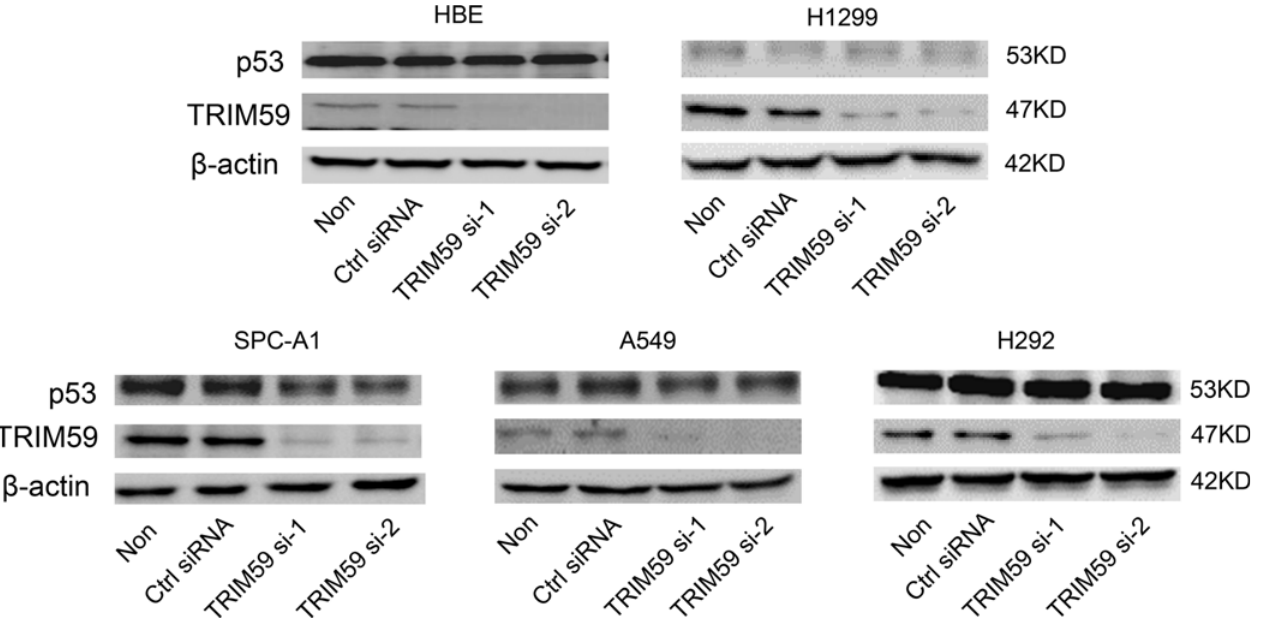
Fig 6. TRIM59 promotes NSCLC cell growth not through p53 signaling pathway. Four types of indicated NSCLC cells and HBE cells transiently transfected with TRIM59 siRNA-1, TRIM59 siRNA-2, control siRNA or untransfected were cultured in RPMI 1640 with 10% FBS for 48 hrs. The protein expression levels of p53 were checked by western blot using anti-p53 and anti-TRIM59 antibodies.